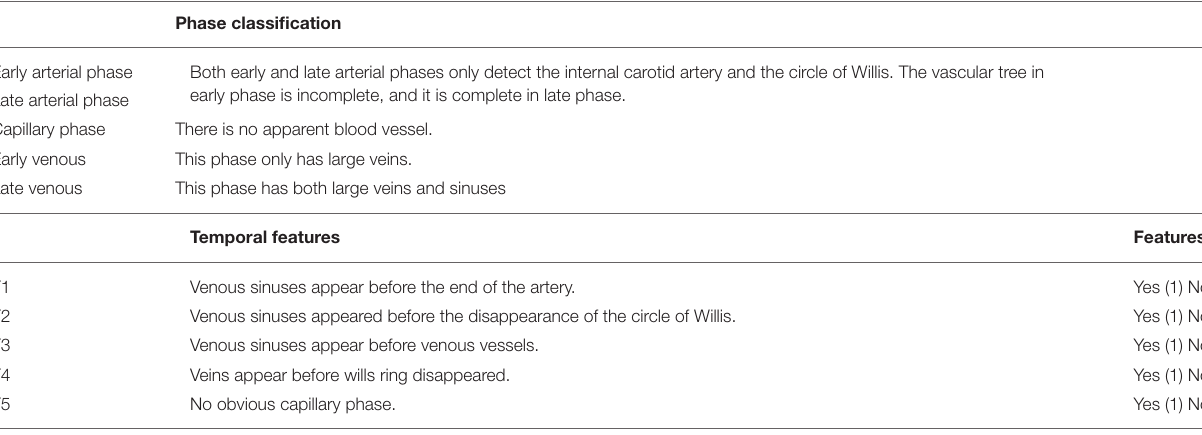
TABLE 3 | Phase classification and temporal features extraction. Phase